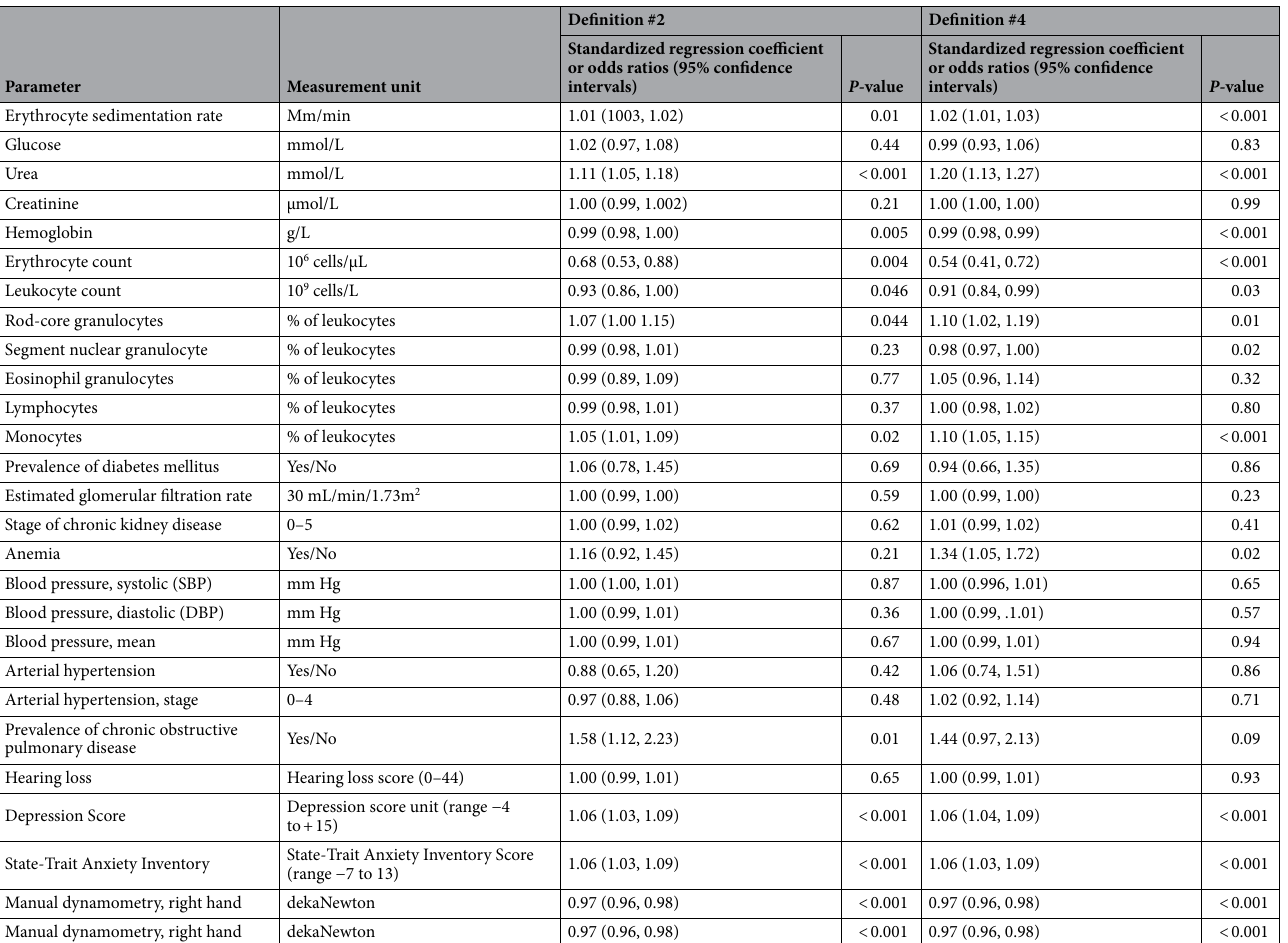
Table 3. Associations (binary univariable analysis) between the prevalence of dry eye disease using definition #2 (dry eye symptoms score was ≥ 2 and Schirmer´s test of < 5 mm) or definition #4 (dry eye symptoms score was ≥ 1, Schirmer test ≤ 5 mm, and a Meibomian gland dysfunction grade of 1 (telangiectasia at the lid margin) or higher) with systemic parameters in the Ural Eye and Medical Study. *Level of education was graded into 8 grades: illiteracy/passing 5 th grade/8th grade/10th grade/11th grade/graduates/specialized secondary education/post